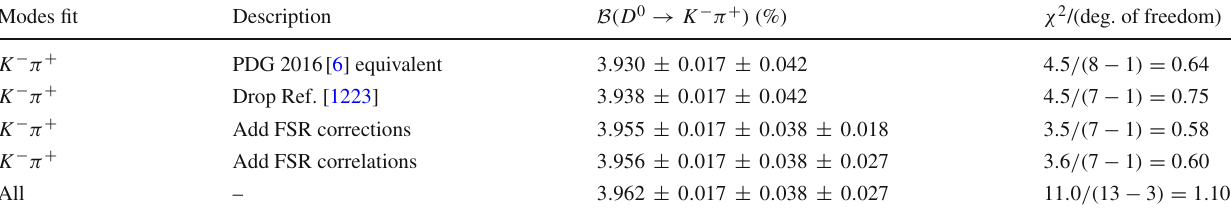
Table 288 Evolution of the D 0 → K − π + branching fraction from a fit with no FSR corrections or correlations (similar to the average in the PDG 2016 update [6]) to the nominal fit presented